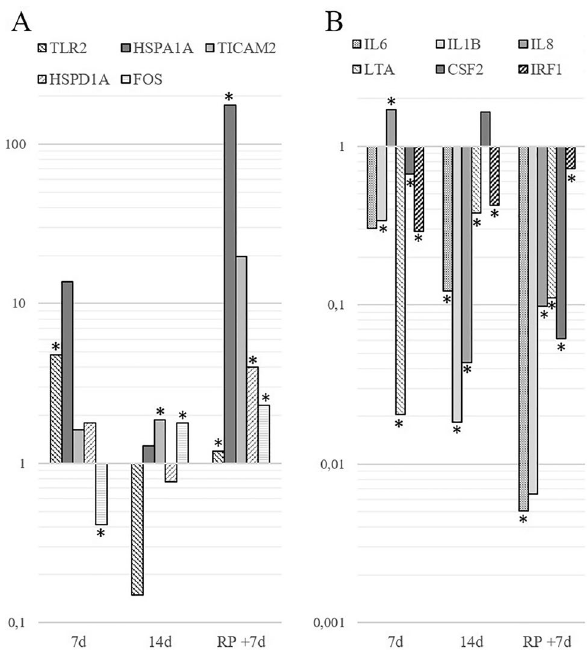
Figure 3. The relative expression (log10) of the genes of interest in the monocytes extracted from the peripheral blood at the indicated time points normalized to the expression of TBP as reference gene and baseline 1 (−7d) as reference sample (ΔΔC T method). ( A ) The relative expression of genes encoding TLR2, TLR adapter molecules (TLR2, HSPA1A, TICAM2, HSPD1, FOS genes). ( B ) The relative expression of IL6, IL1B, IL8, LTA, CSF2, and IRF1genes, which encode the participants of TLRs’ signaling cascades. Asterisk (*) indicates p -value ≤ 0,05 in Wilcoxon